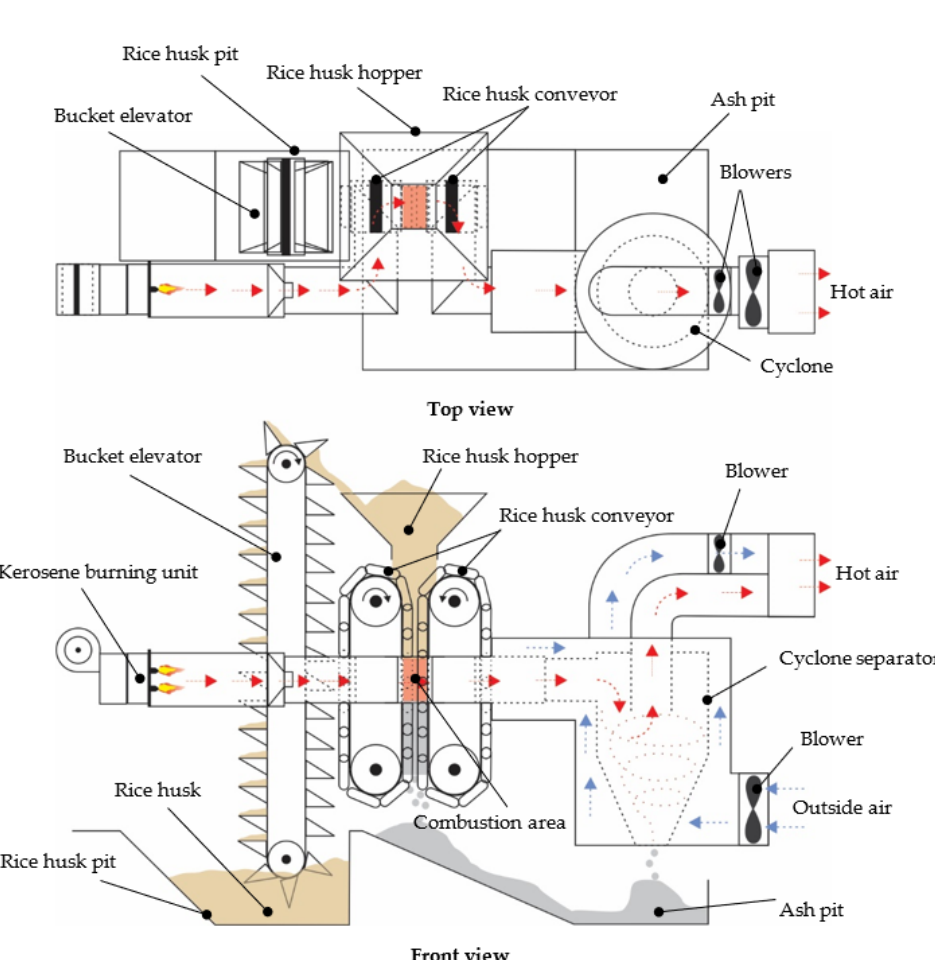
Figure A1. Proposed hybrid rice husk burner with fluidized bed (continuous type). Description: A hybrid rice husk burner with a fluidized bed as mentioned in the above figure will be designed based on the results obtained from the current study. Two opposite flaps of rice husk conveyors compact the rice husk into the desired bulk density as it reaches the position of the combustion area in a way it forms a temporary chamber for combustion. Rice husk is supplied to the combustion area continuously by the rice husk conveyor from the rice husk hopper which is located above the rice husk burner. Rice husk will be stored in a rice husk pit, and it will be transferred to the rice husk hopper by a bucket elevator. Rice husk charcoal generated after combustion will be collected in the ash pit, which is located below the combustion area. Ash particles flowed with the heated air will be extracted through a cyclone separator and collected in the same ash pit. Hot air (red arrows) generated by rice husk combustion will be purified by the above-mentioned cyclone separator and the temperature of the air will be controlled by mixing with outside ambient air (blue arrows) to achieve the temperature requirement of the